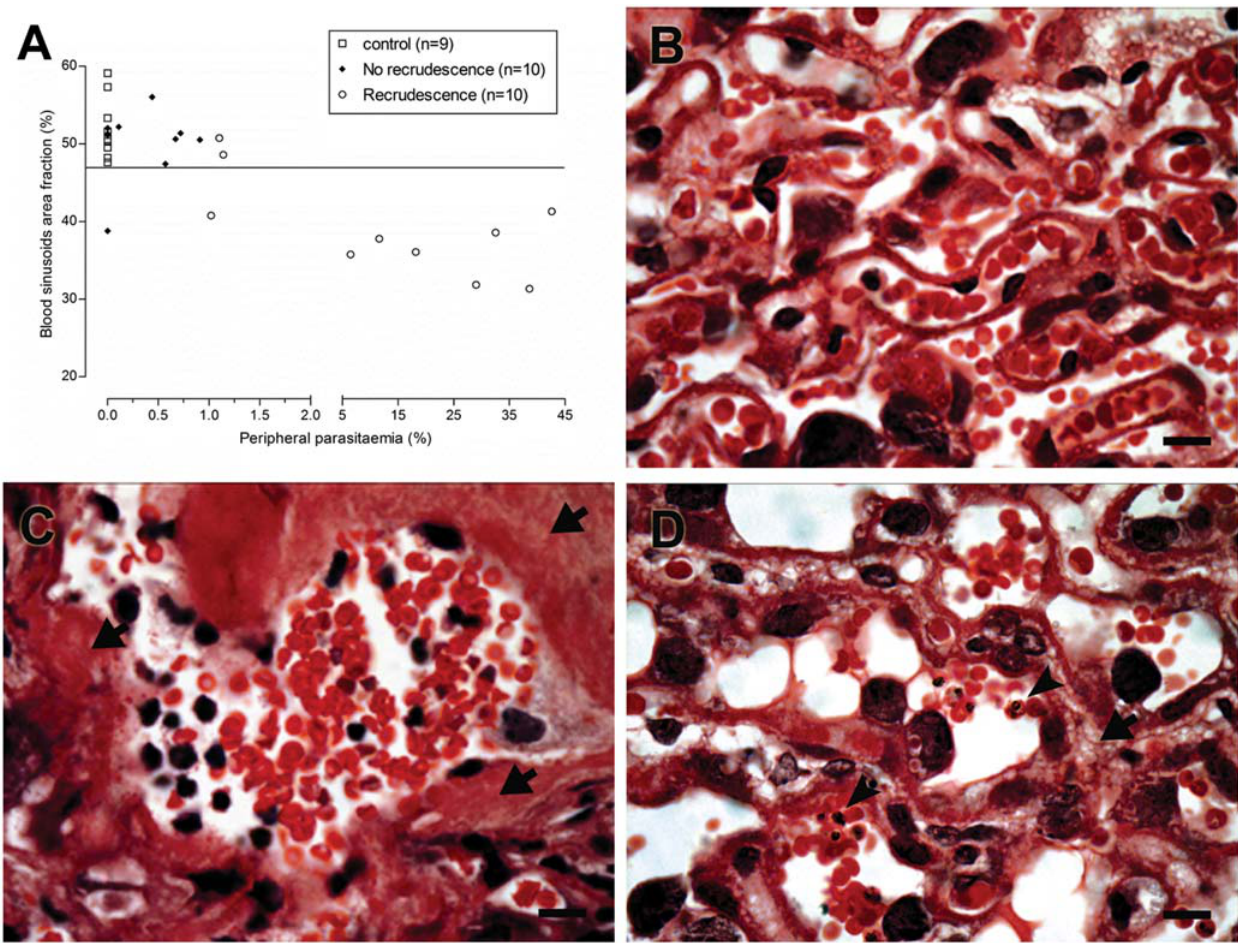
Figure 2. Peripheral parasitemia correlates with the reduction of placental blood sinusoids area. (A) The blood sinusoidal area is plotted against the peripheral parasitemia peak observed in the pregnancy of primiparous females. The area of placental blood sinusoids, expressed as a fraction of the total placental area, was obtained using an automated morphometric procedure as described in Materials and Methods section. In recrudescent females, the degree of parasitemia was correlated with sinusoidal area reduction (correlation coefficient for recrudescent females is 0.45, P -value=0.0012). Representative photomicrograph of placental sections HE stained from non-infected (B) and recrudescent (C–D) mothers. Accumulation of inflammatory cells (C), trophoblast thickening (arrows) and presence of iRBC (D) in blood sinusoids (arrowheads) are evidenced in placenta tissue from recrudescent mothers. Scale bars represent 15 m m in (B–D).